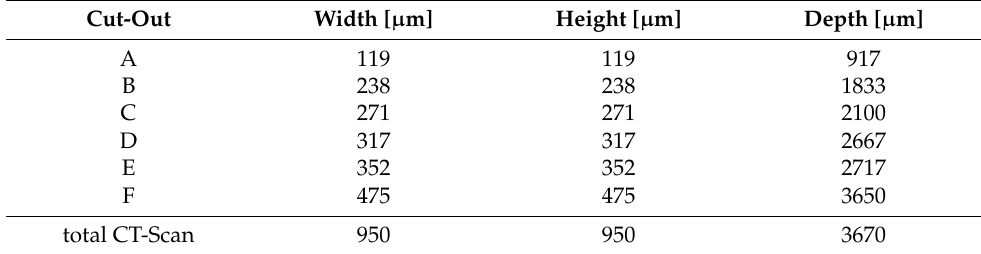
Figure 5. Cut-outs A–F from the overall geometry for convergence studies. Table 2. Size information of